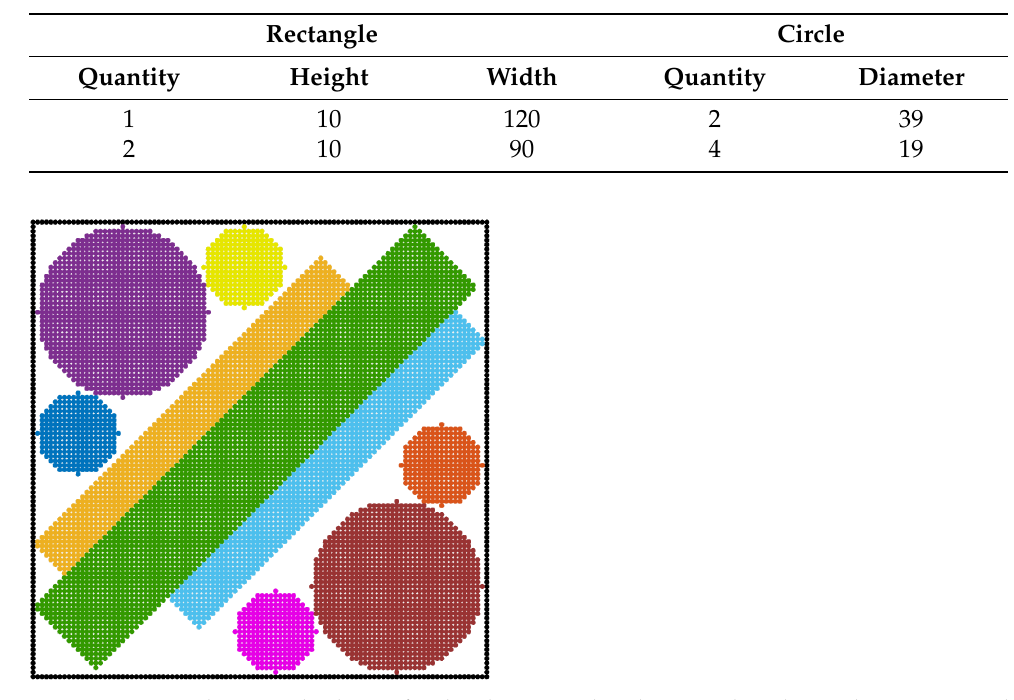
Table 4. Quantities and dimensions of the rectangular and circular objects used in the second study involving rotational degrees of freedom.